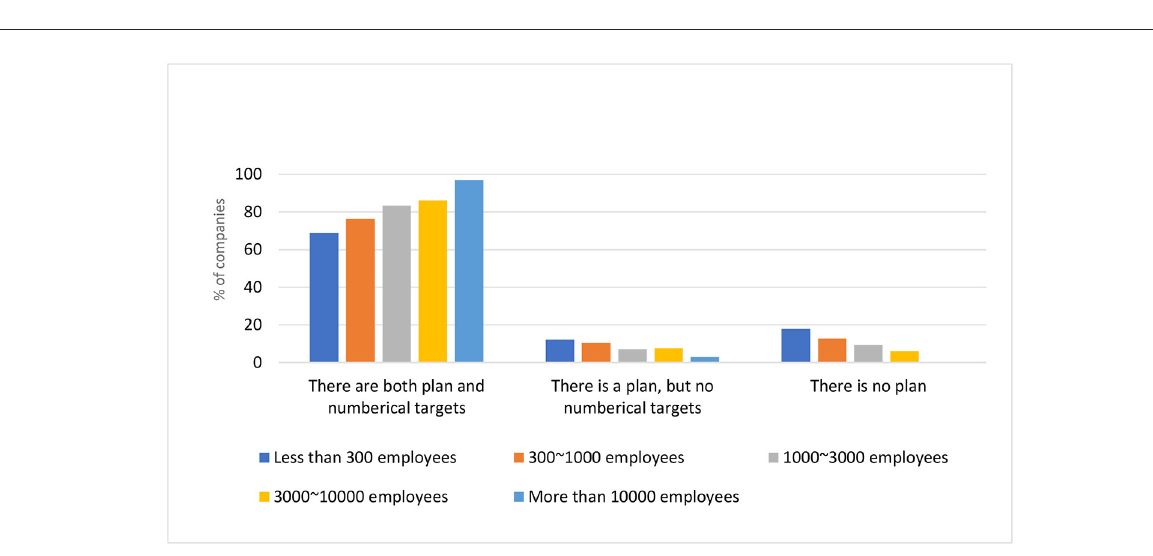
FIGURE8 Plan and numerical targets for